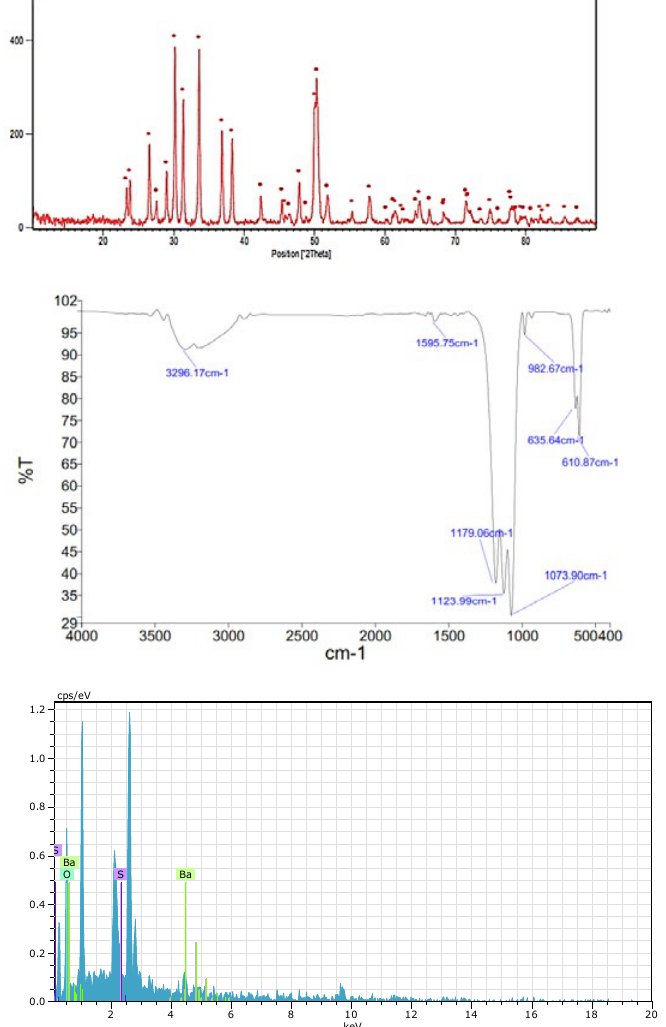
Fig. 4. Pure BaSO synthesized nanoparticles characterization, (a) XRD, (b) FT-IR, (c) EDS 4 Table 2. Comparison of this study with other ones to synthesize BaSO4